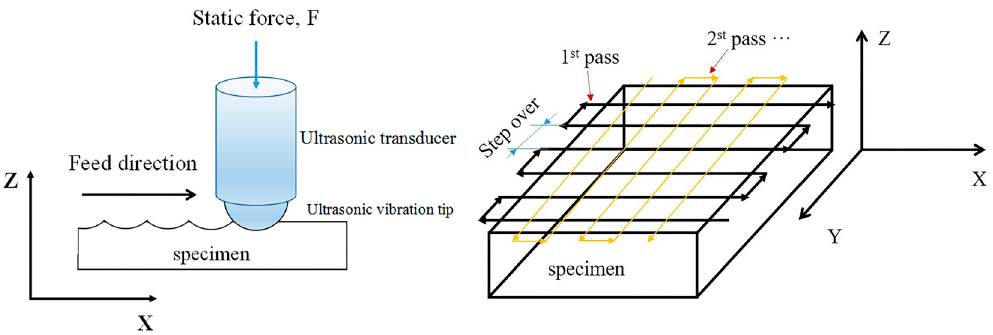
Figure 2. Schematic diagram of the treatment strategy.